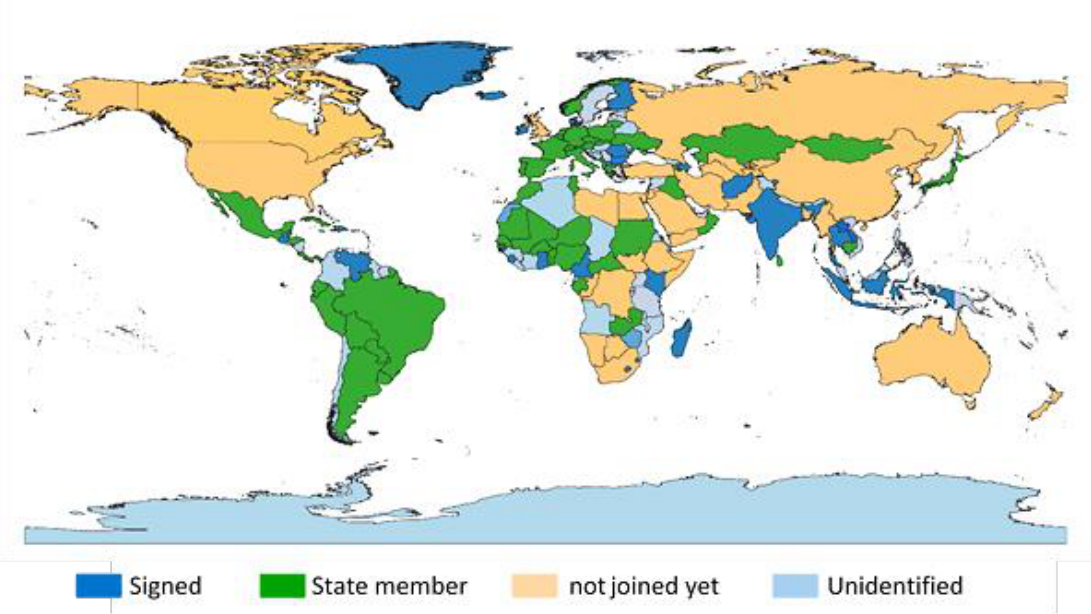
Figure 1. Adapted from United Nation Human Right Office of the High